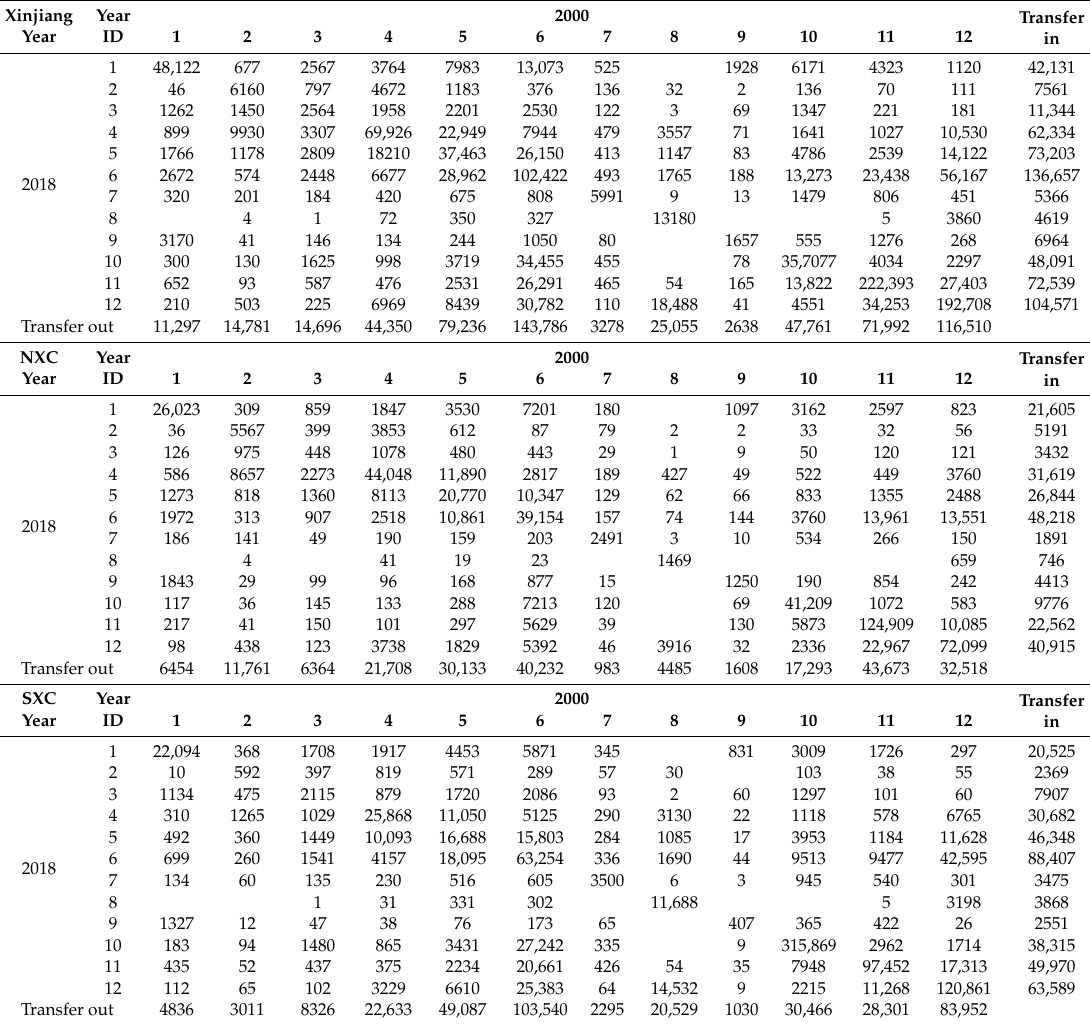
Table 4. Transfer matrix of LULC in 2000 and 2018 (km 2